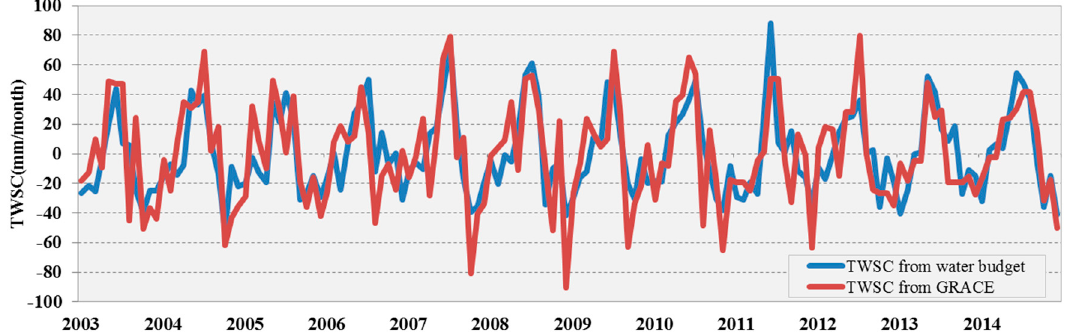
Figure 3. Comparison of terrestrial water storage change (TWSC) in the Yangtze River Basin from 2003 to 2014, derived from Gravity Recovery and Climate Experiment (GRACE) data and water budget estimates.